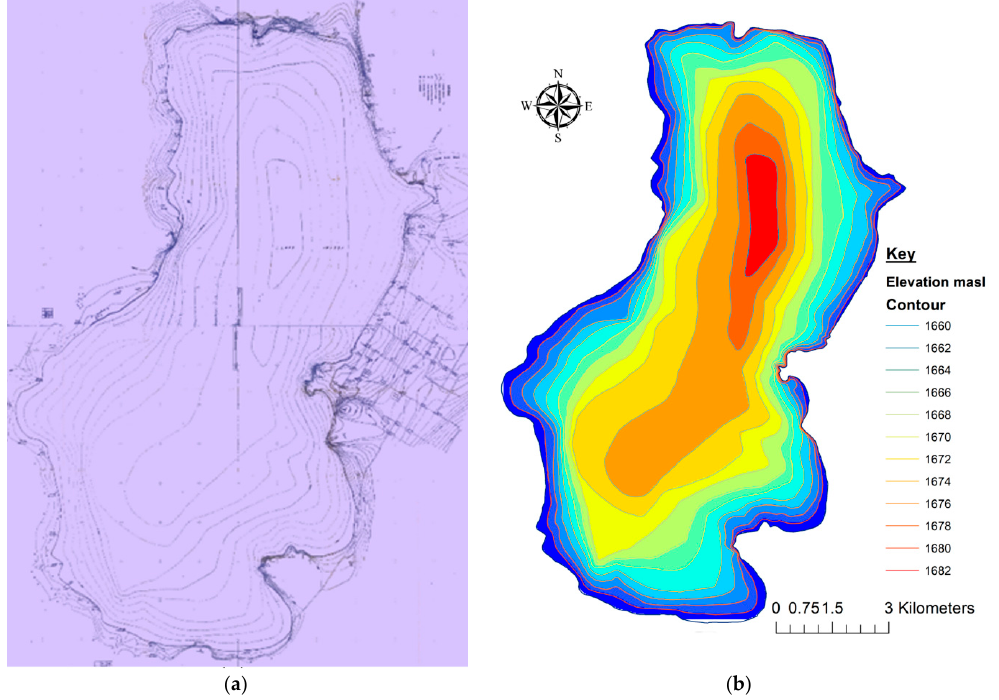
Figure 2. Water Works Design and Supervision Enterprise 1999 bathymetric map. ( a ) Original scanned map; ( b ) reconstructed map.